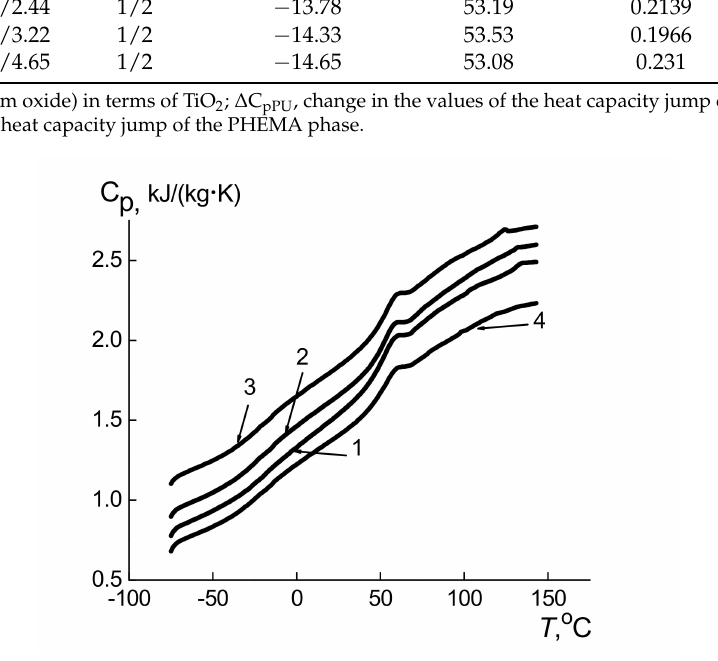
Figure 5. Temperature dependences of heat capacity for IPNs (1); OI IPNs-1 (2), OI IPNs-2 (3), OI IPNs-3 (4). The composition of the samples is given in Table